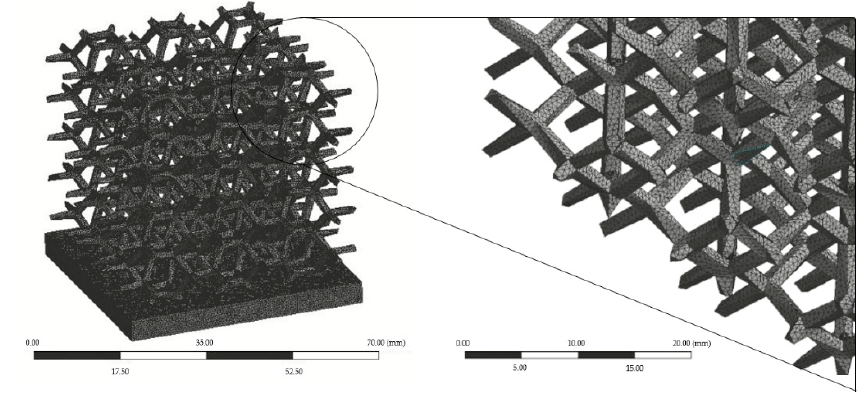
Figure 2. Lattice heat sink mesh.